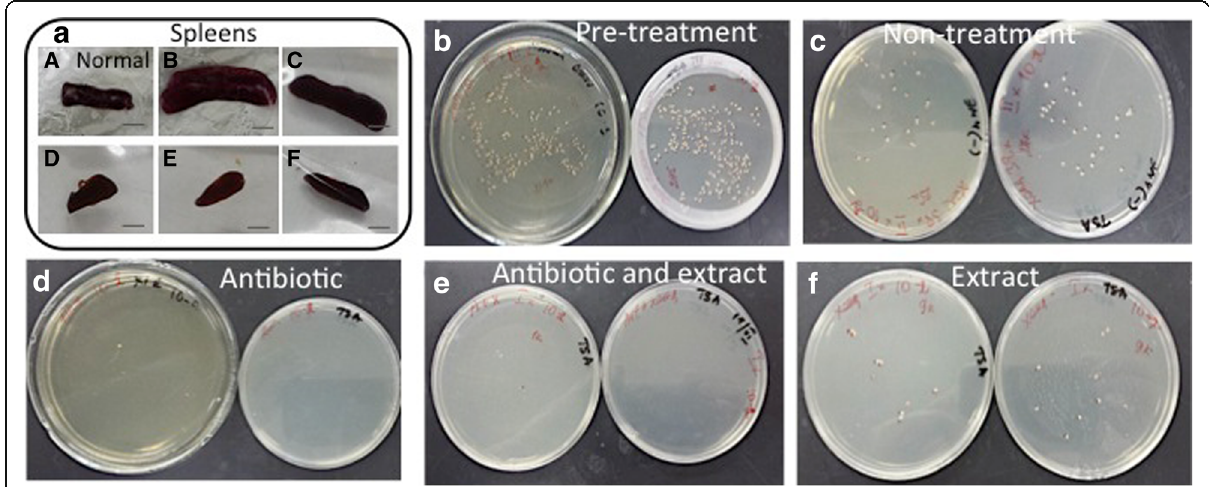
Fig. 1 Splenic enlargement in a Brucella -infected mouse compared with a normal mouse and countable Brucella colonies in 0.1 g spleen homogenate from mice in the following groups inoculated on TSA plates. a health control mouse spleen, b pretreatment, c non-treatment, d doxycycline only, e combination of antibiotic and root extract, f C. mongolica root extract